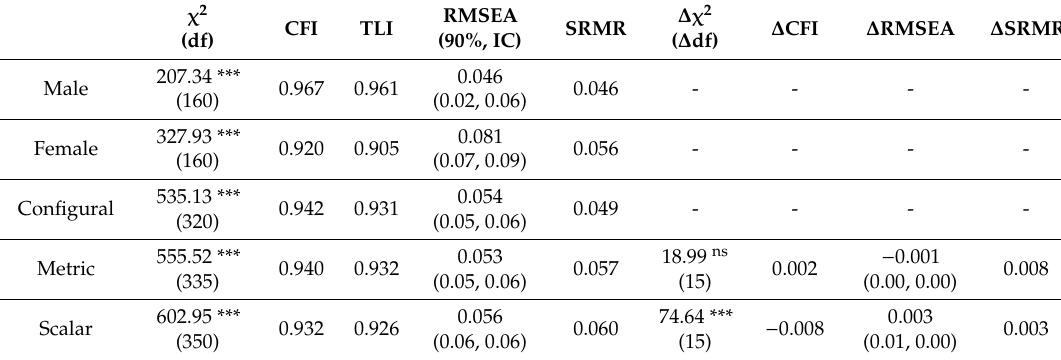
Table 2. Test of the invariance of the Selfitis Behavior Scale across gender